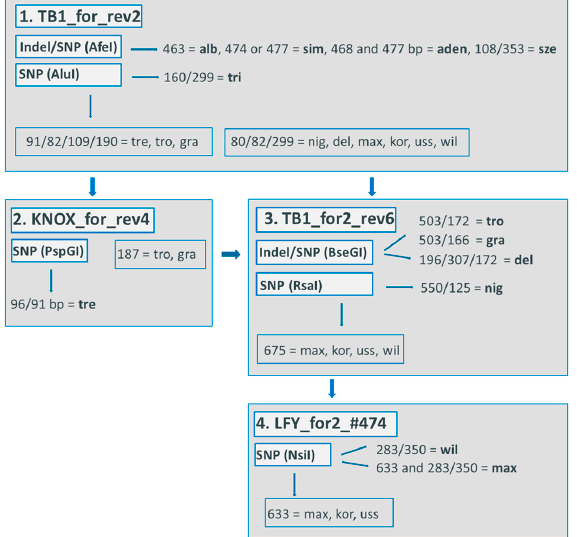
Figure 2. Procedure of exclusion for nuclear regions: a step-by-step procedure for the use of four nuclear regions to differentiate up to 12 of 14 poplar species. For the fourth step, P. maximowiczii could be homozygous, and therefore remain uncut. Then, it either cannot be differentiated from P. koreana and P. ussuriensis, or alternatively, P. maximowiczii can be hetereozygous, in which case the differentiation from the other two species is possible. Abbreviations and explanation for the species: see the legend of Figure 1 and the main